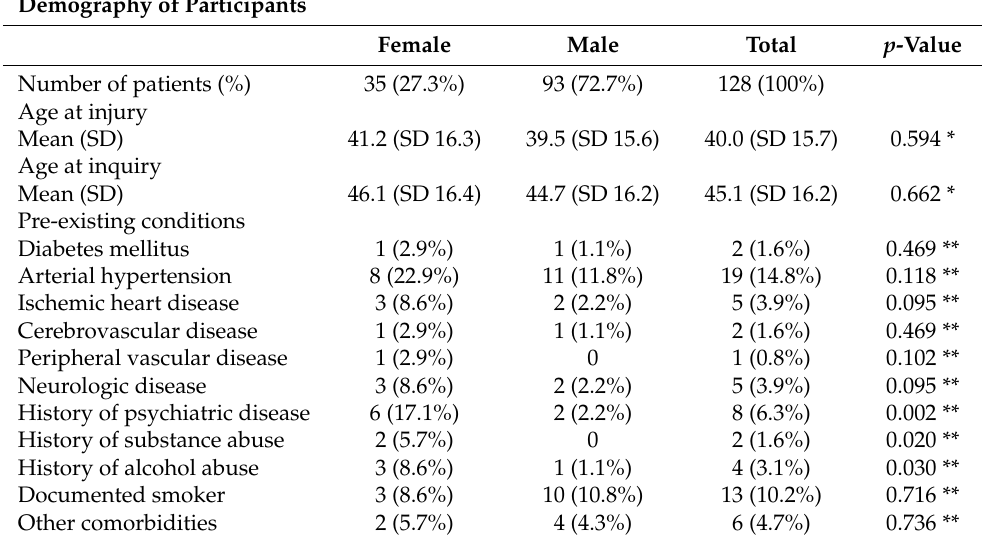
Table 2. Demography of